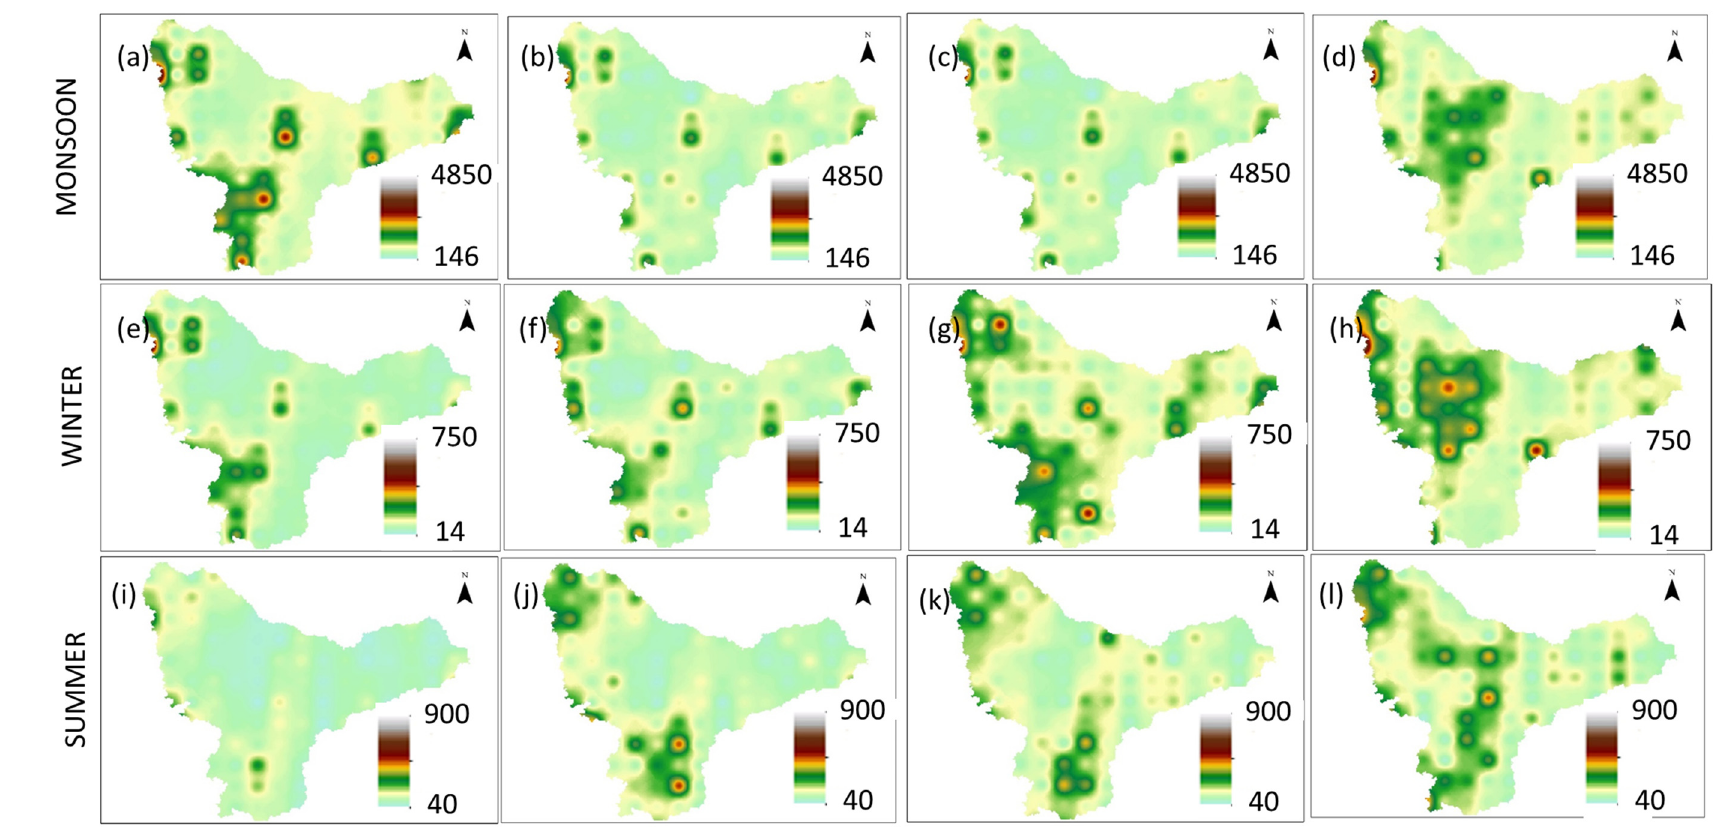
Figure 5. Seasonal average precipitation variation in the Krishna basin for Historic, Future1, Future2, and Future3 periods of Monsoon ( a – d ), winter ( e – h ) and summer ( i – l ) under the RCP 4.5 scenarios.